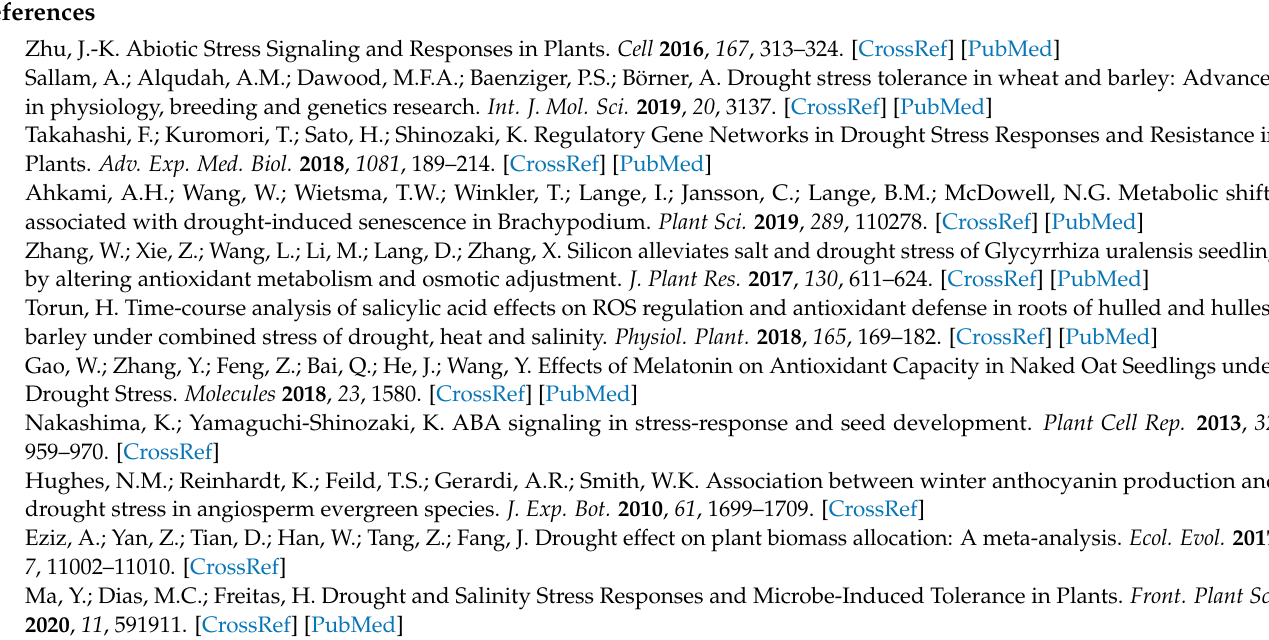
Figure S2: Principal component analysis among the 12 samples of Avena sativa , Figure S3: Similarities of Avena sativa to other species, Figure S4: Annotation of the assembled unigenes in Avena sativa transcriptome in GO database, Figure S5: Annotation of the assembled unigenes in Avena sativa transcriptome in KEGG database, Figure S6: Annotation of the assembled unigenes in Avena sativa transcriptome in TF database, Figure S7: The relative expression levels of 20 DEGs identified in the comparison between RNA-Seq and qRT-PCR, Table S1: Specific primer pairs for qRT-PCR, Table